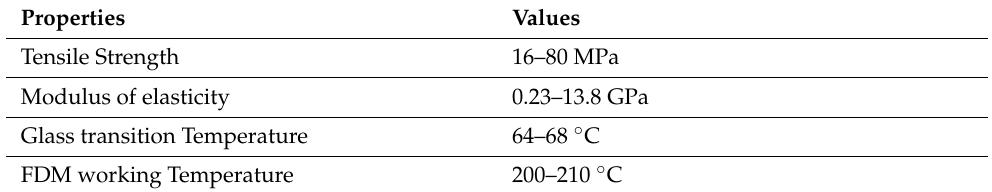
Table 1. Properties of PLA used in the current study according to the manufacturer.